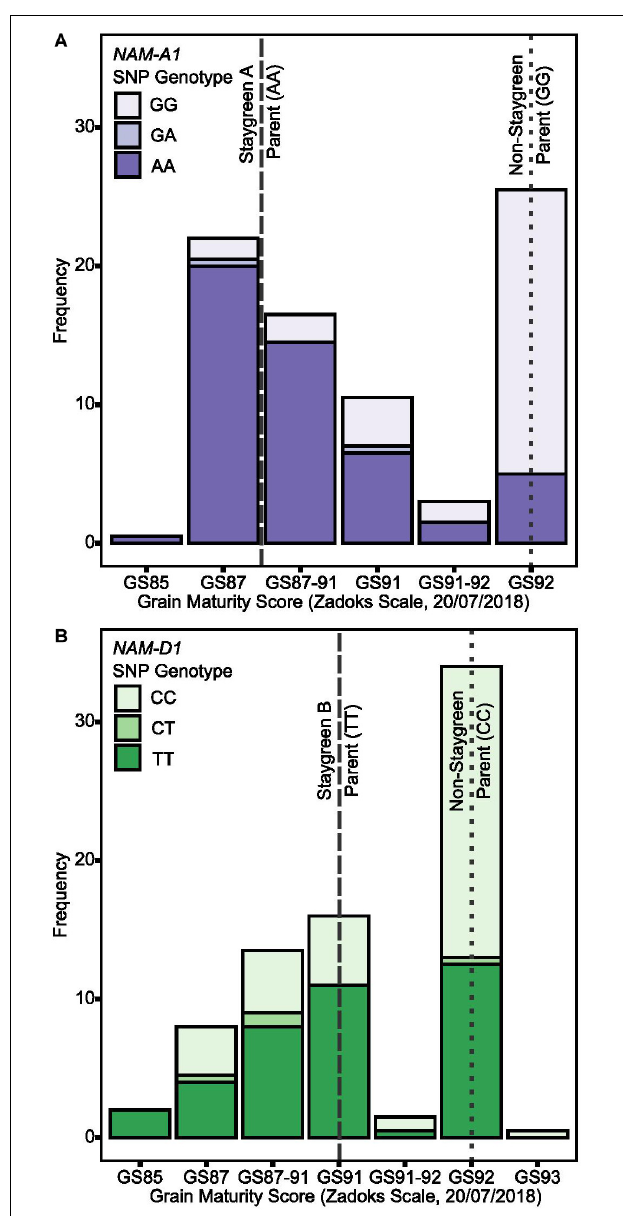
FIGURE 7 | Staygreen phenotypes are positively associated with delayed grain maturation. Grain maturation of RIL populations segregating for senescence traits was assessed when significant differences in grain moisture content between parental lines (Staygreen A vs. non-staygreen parent and Staygreen B vs. non-staygreen parent) were previously observed. Grain maturation of RILs homozygous for mutations in NAM-A1 (Staygreen A) (A) and NAM-D1 (Staygreen B) (B) was delayed, with scores starting from GS85 onwards, compared to the predominant score of GS92 for RILs homozygous for the non-staygreen allele. Grain scored according to the Zadoks scale (Zadoks et al., 1974), assisted by “The Wheat Growth Guide” (AHDB, 2018). Bar charts represent RIL populations, n ≥ 75 (two replicates) segregating for a mutation NAM-A1 (Staygreen A) (A) or NAM-D1 (Staygreen B) (B) ; allelic combinations, GG/CC = homozygous non-staygreen, AA/TT = homozygous Staygreen A/Staygreen B, GA/CT = heterozygous. Lines represent parental means ( n ≥ 3 per replicate); staygreen parents (dashed), non-staygreen parent